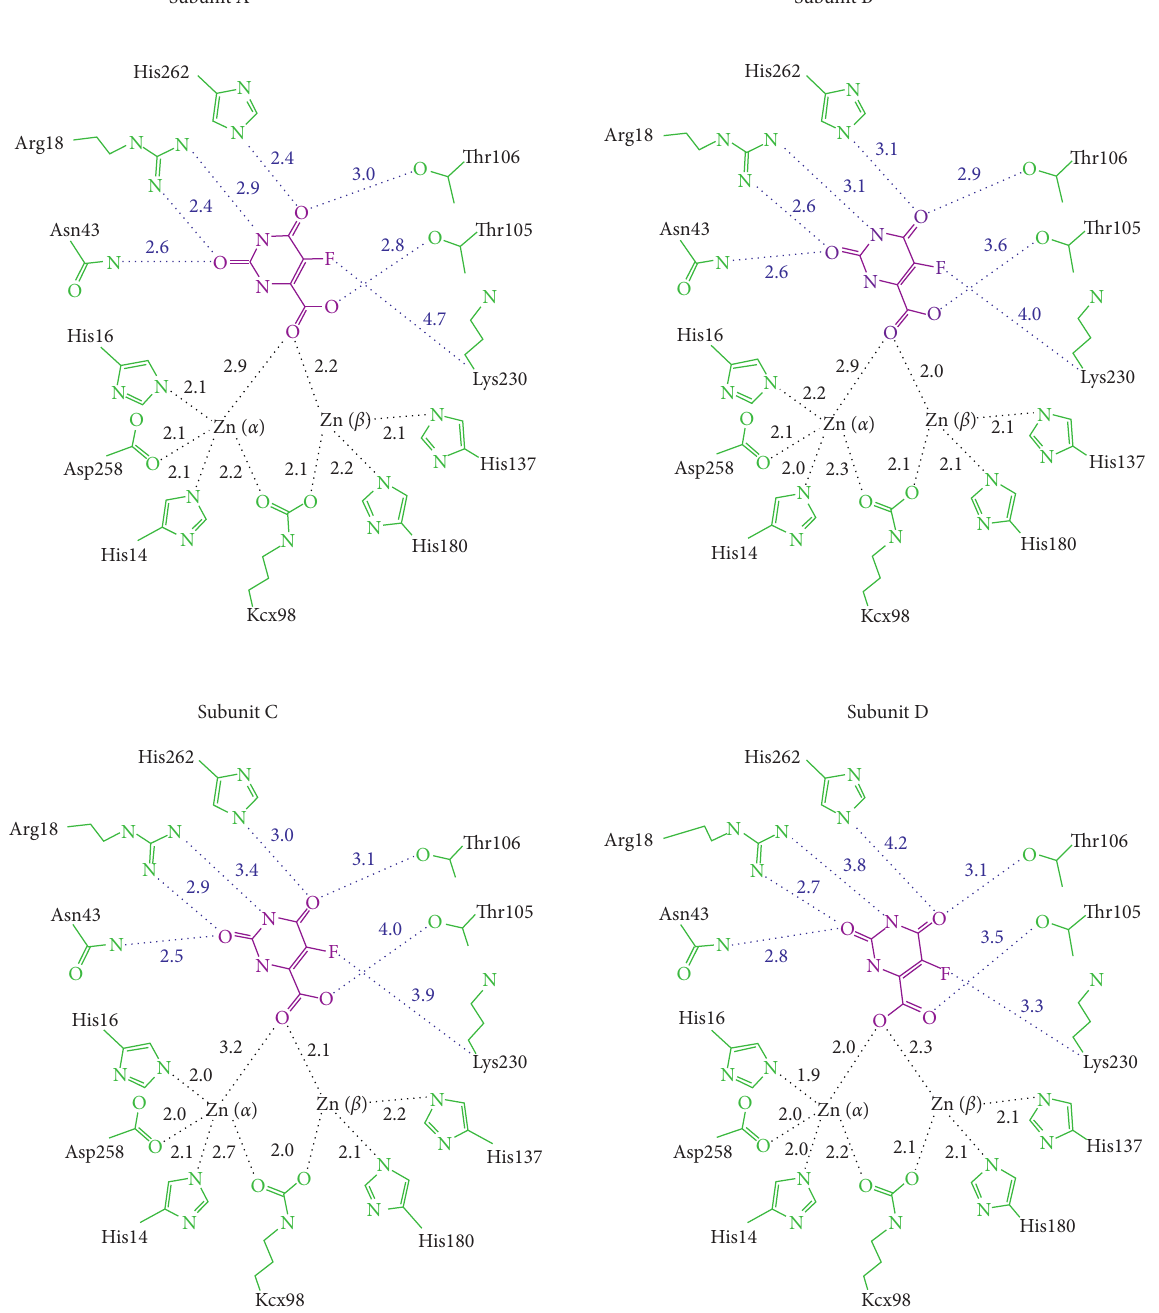
Figure 4: 5-FOA binding mode of ScDHOase. Arg18, Asn43, His262, Thr105, Thr106, and Lys230 of ScDHOase were involved in the 5-FOA